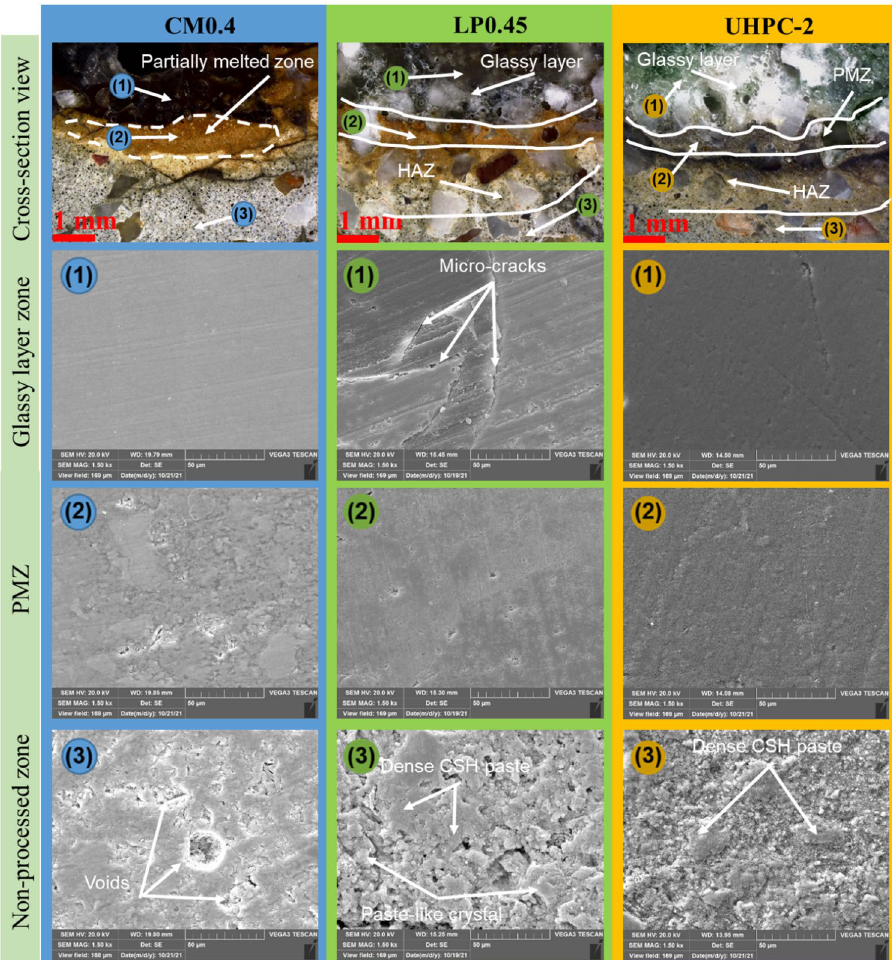
Figure 14. Microstructure of Glassy layer, PMZ, and non-processed zone on cross-section views of CM0.4, LP0.45, and UHPC-2 samples.